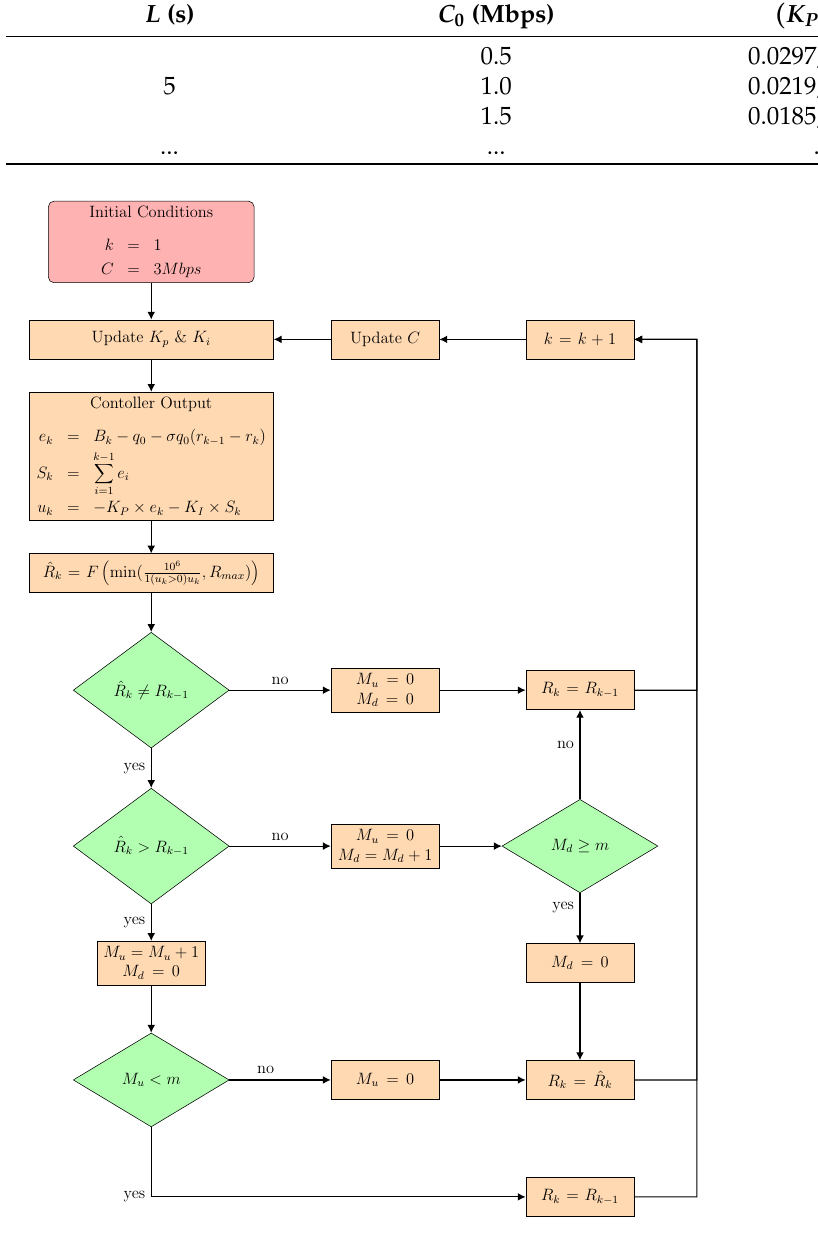
Figure 2. LQE Adaptive Bit Rate